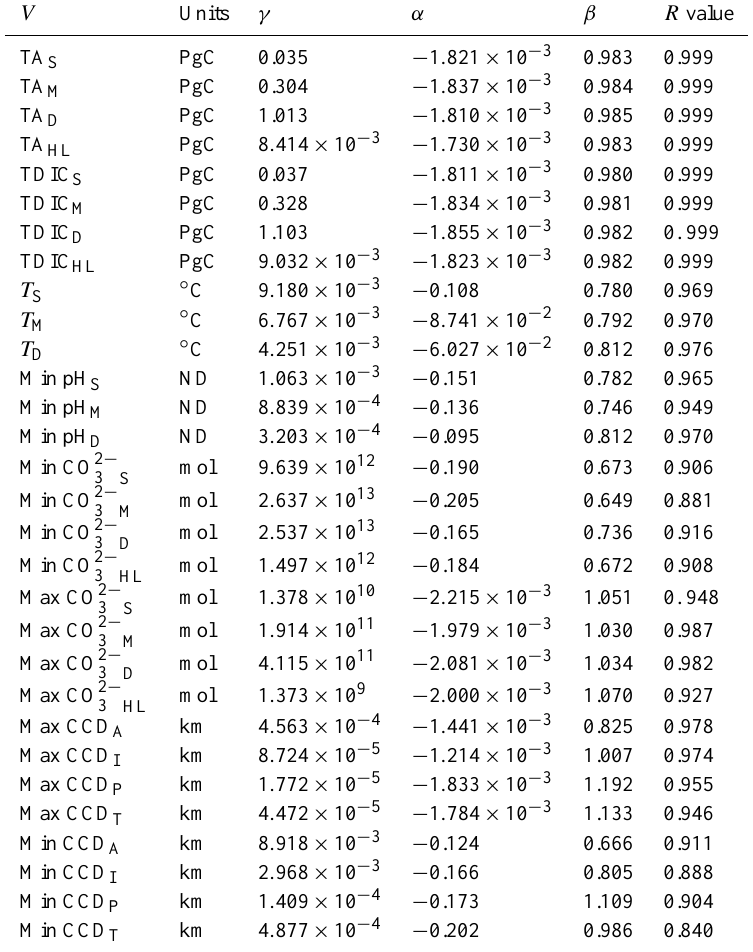
Table 9. Power law scaling for Paleocene and Eocene configuration, ocean boxes, and (cid:49)V = γD α E β . D in yr and E in